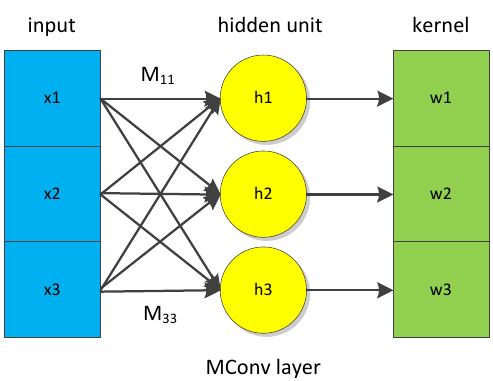
Figure 2. Structure of the matching convolutional (MConv)